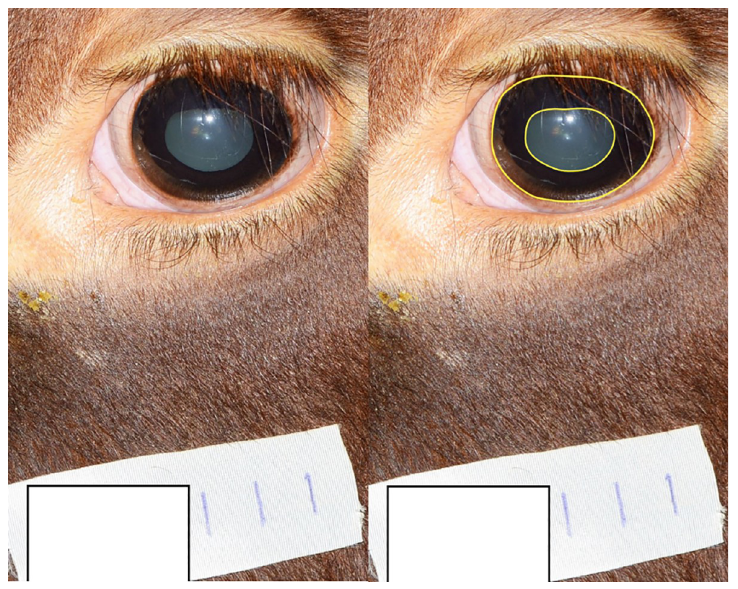
Fig 3. Photograph illustration for the calculation of relative area of the pupil (RAP). The yellow marks in the right photograph indicate the pupil area and the iris area. RAP was calculated by dividing the area covered by the pupil with the area area circumscribed by the peripheral iris at the limbus